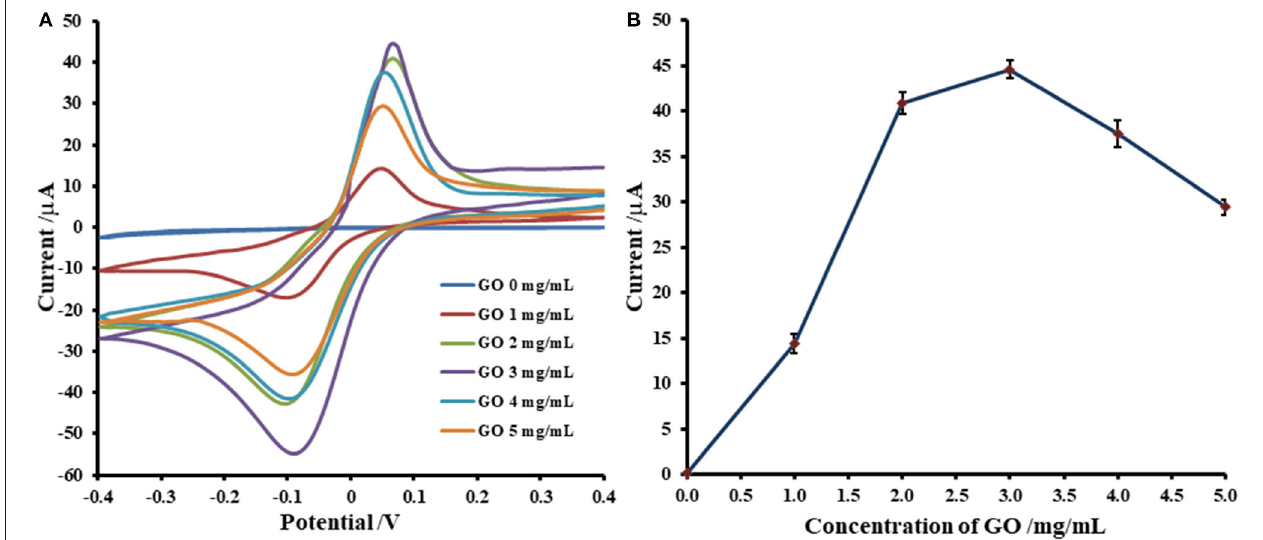
FIGURE 1 | Optimization of GO concentration for Cu(II) ions adsorption on GO-modified SPCE; (A) CVs of Cu(II)/GO-modified SPCEs with different GO contents and (B) corresponding oxidation peak currents, in 0.20 M acetate buffer (pH 5.5).